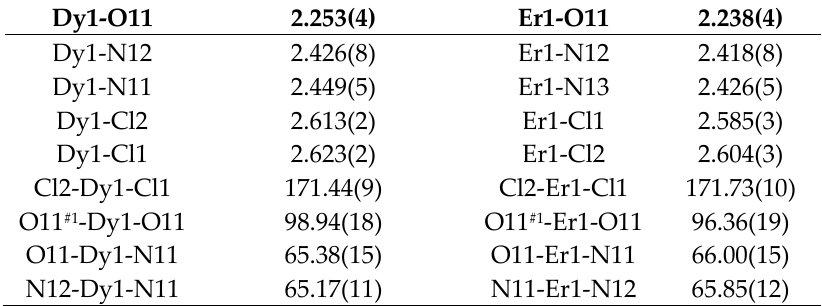
Figure 1. Ellipsoids diagram (50% probability) for [Dy(H 2 daps)Cl 2 ] - and [Er(H 2 daps)Cl 2 ] - anions in DyH 2 daps and ErH 2 daps . The (CH 3 ) 4 N + counterions have been omitted for clarity. Table 2. Main bond distances (Å) and angles (º) for DyH 2 daps and ErH 2